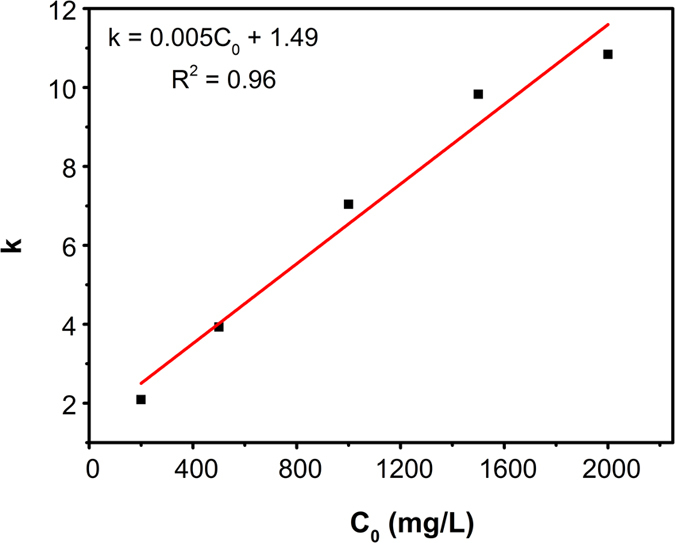
Relationship between k and C0.